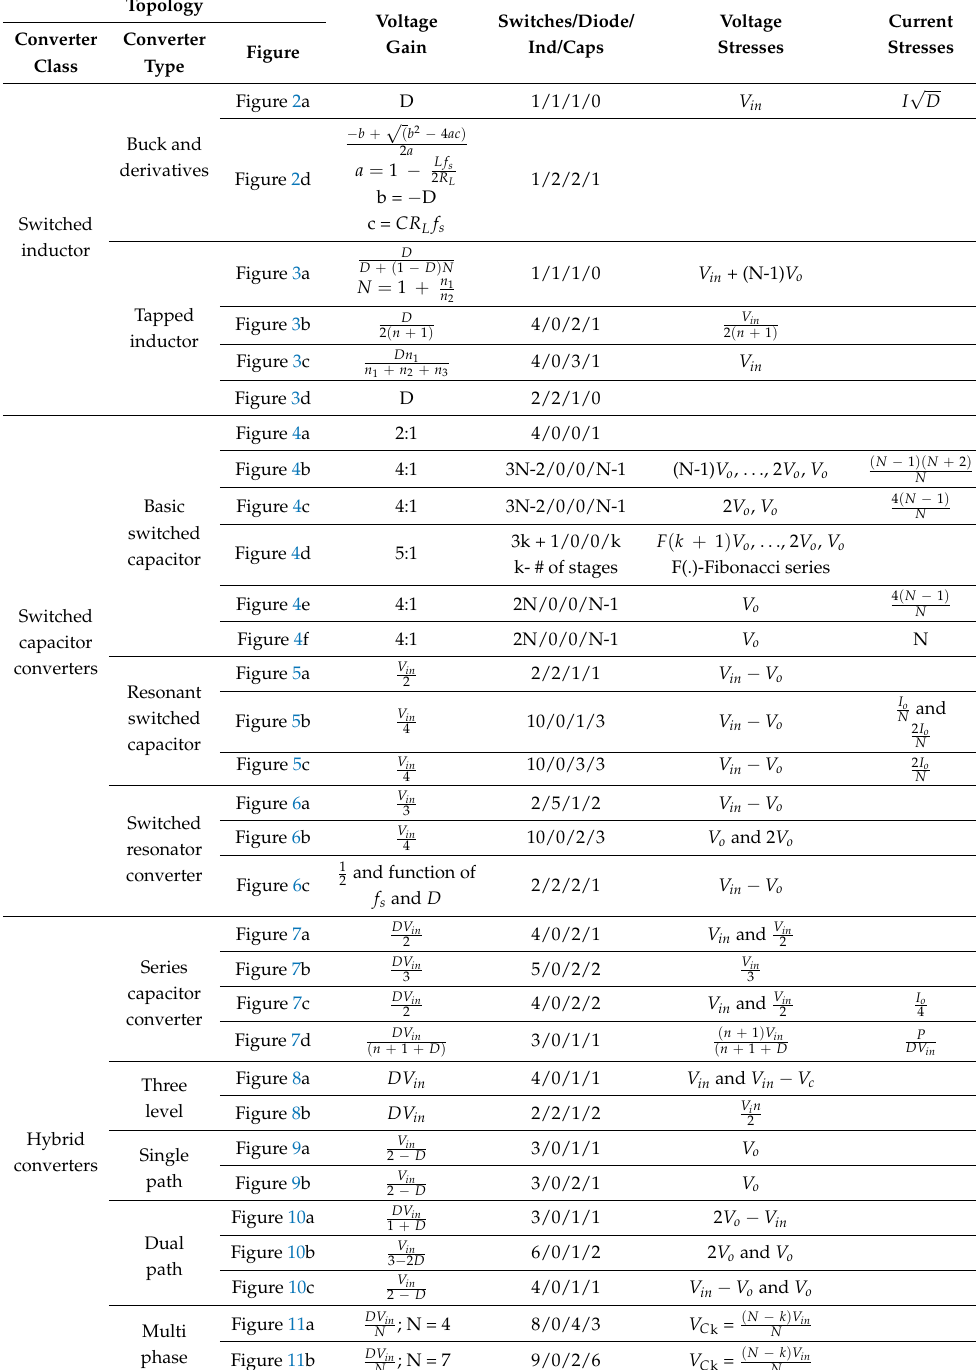
Table 2. Converter comparison, considering voltage gain, and number of semiconductor and passive